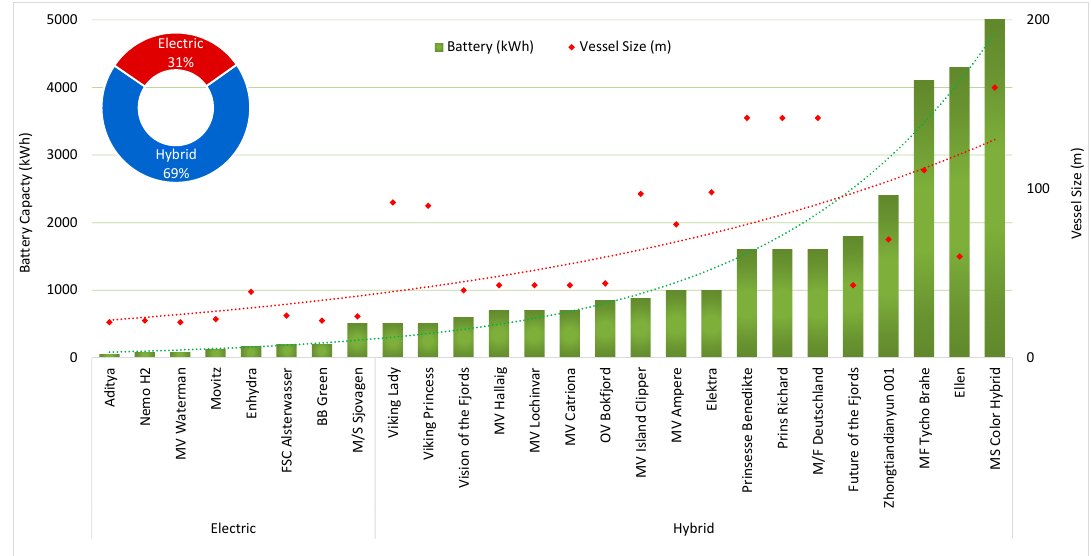
Figure 5. Companywide electrification of ships.